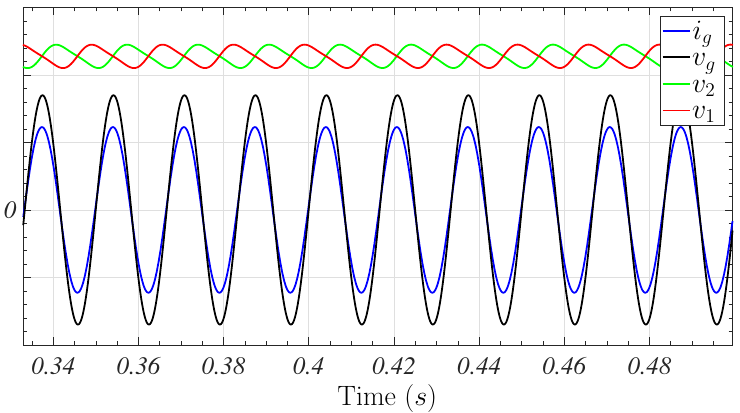
Figure 18. Waveforms obtained for CV3; i g : 1 A/div, v g , v 1 and v 2 : 100